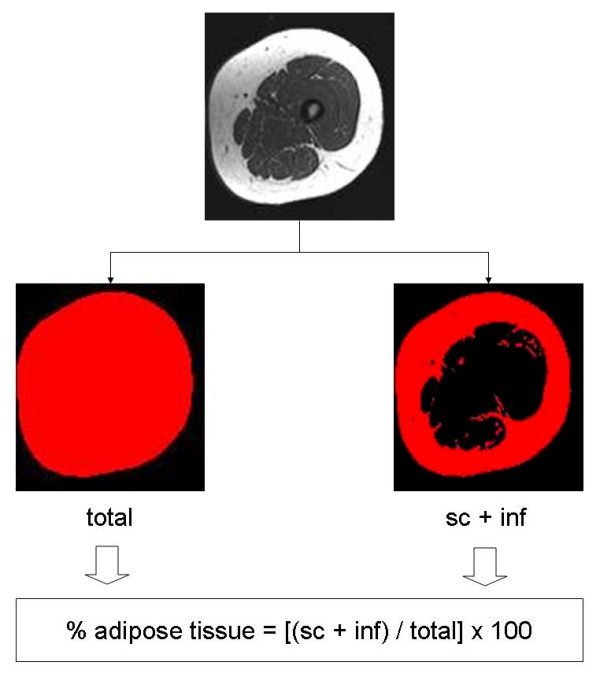
Quantification of percent adipose tissue. For each of the 17 transaxial slices in a given anatomical section, both the total volume and the total subcutaneous (sc) and connected infiltrated (inf) fat volumes were selected using the Connected Threshold Grower tool. Their corresponding volumes were determined using the Voxel Counter tool. The percent adipose tissue was calculated for each slice by dividing the total voxels determined for the sc + inf fat by the total voxels for the slice. The percent adipose tissue was determined for each slice alone and also for the overall section, combining the results from all 17 slices.